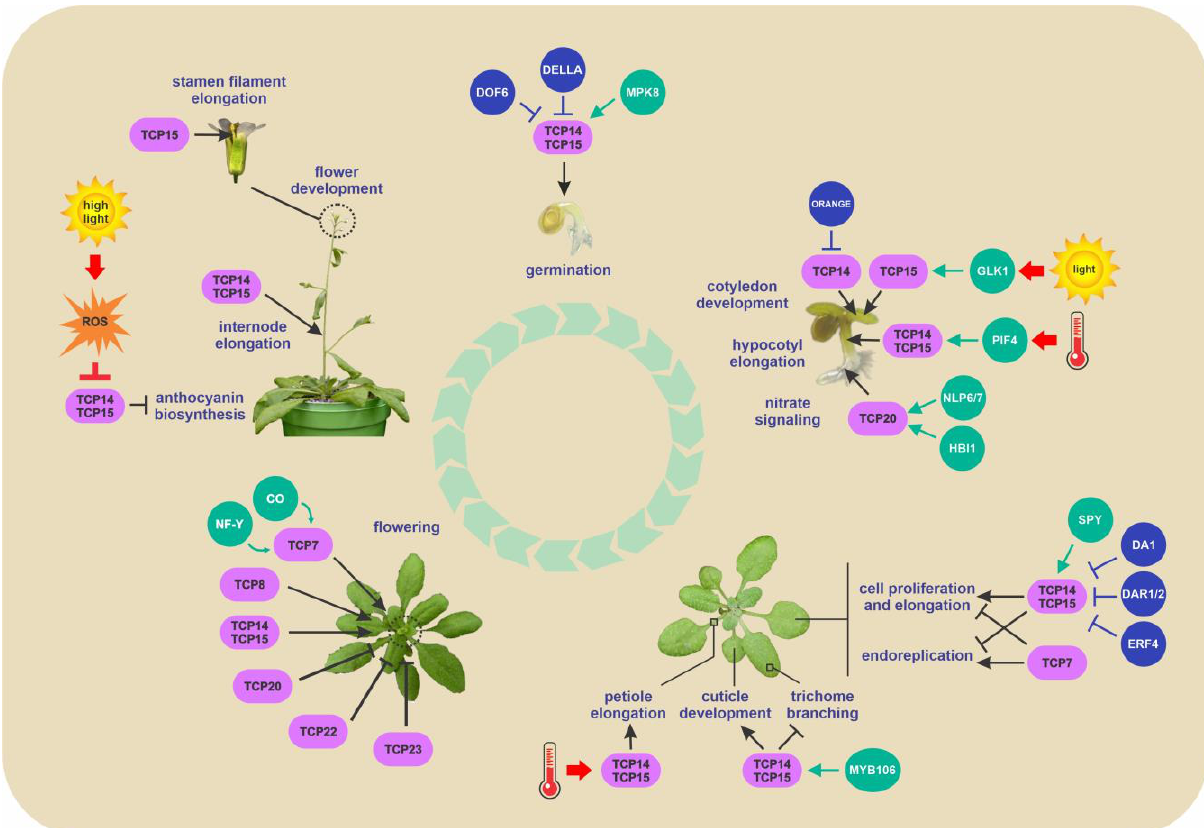
Figure 2. Scheme of the growth and developmental processes regulated by class I TCPs in Arabidopsis . The environmental conditions and interacting proteins that regulate class I TCP activity or stability are indicated. TCP-interacting proteins are shown as spheres. Green arrows and blue T-shaped lines indicate promotion and inhibition of TCP activity or stability, respectively. Red arrows and T-shaped lines indicate stimulatory and inhibitory effects by exogenous factors, respectively. The positive and negative regulatory actions of class I TCP proteins in biological processes are indicated by black arrows and T-shaped lines, respectively. For the purposes of illustration, some TCP-modulated processes are shown in one life stage, but may be operative also in other stages; see text for details.